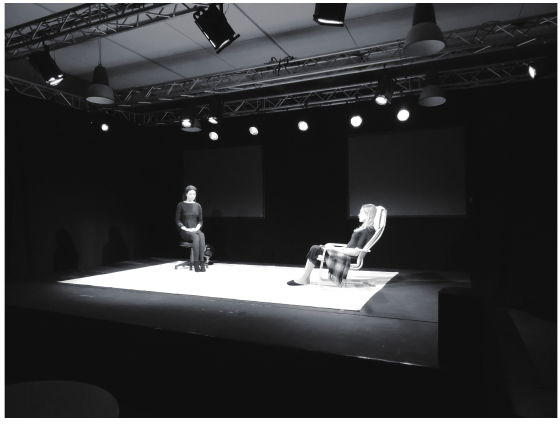
Figure 3. Stage set.